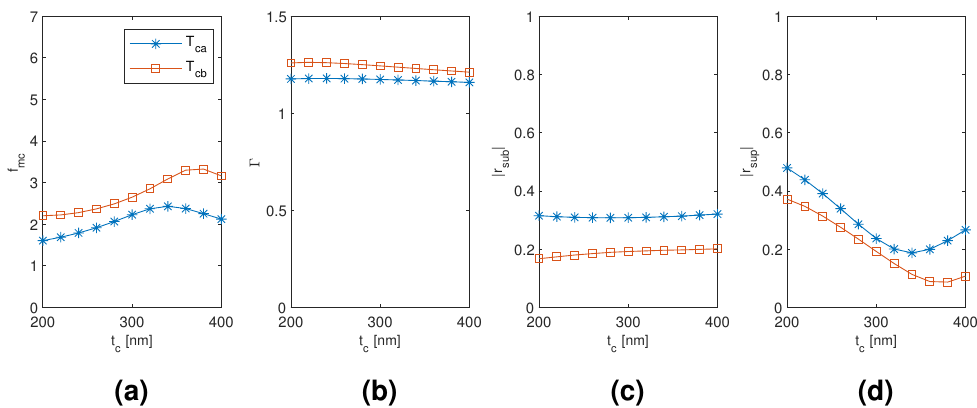
Figure 16. The results for the coated tetramer T ca and T cb mode as a function of the coating thickness with the diameter and separation of the nanowires corresponding to the point of modal cost function minimum for each mode (as listed in Table 2). ( a ) modal cost function value; ( b ) modal confinement factor; ( c ) substrate modal reflection coefficient magnitude; ( d ) superstrate modal reflection coefficient magnitude.